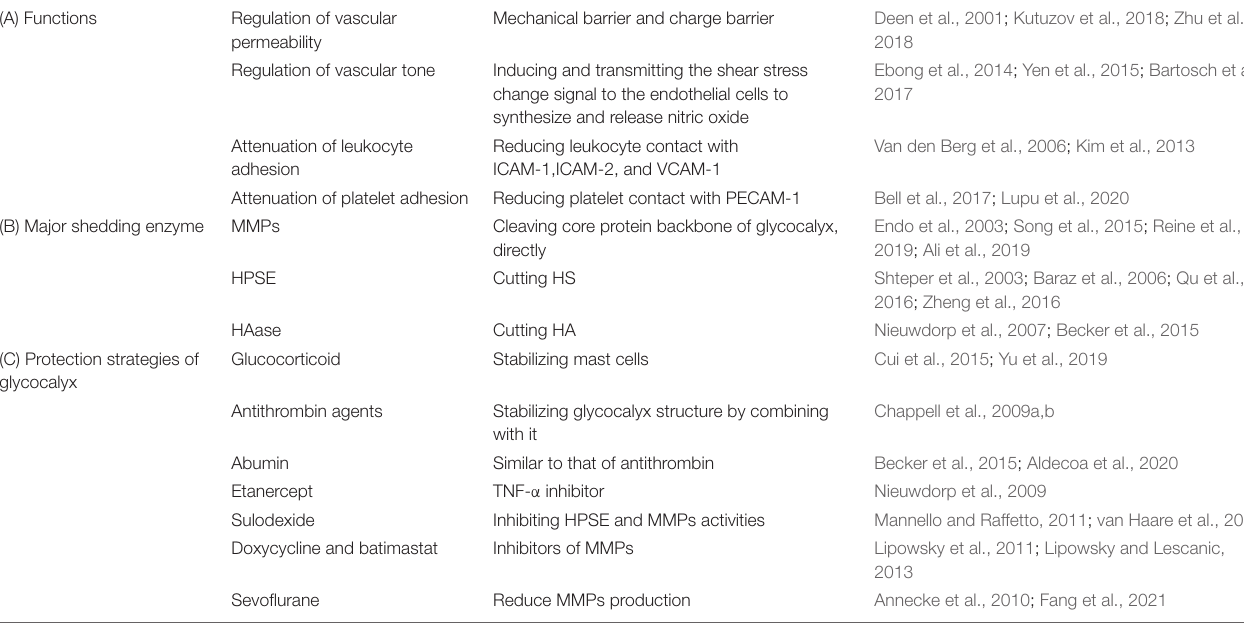
TABLE 1 | The function, shedding enzyme and protection strategies of glycocalyx in cerebrovascular. (A) Functions